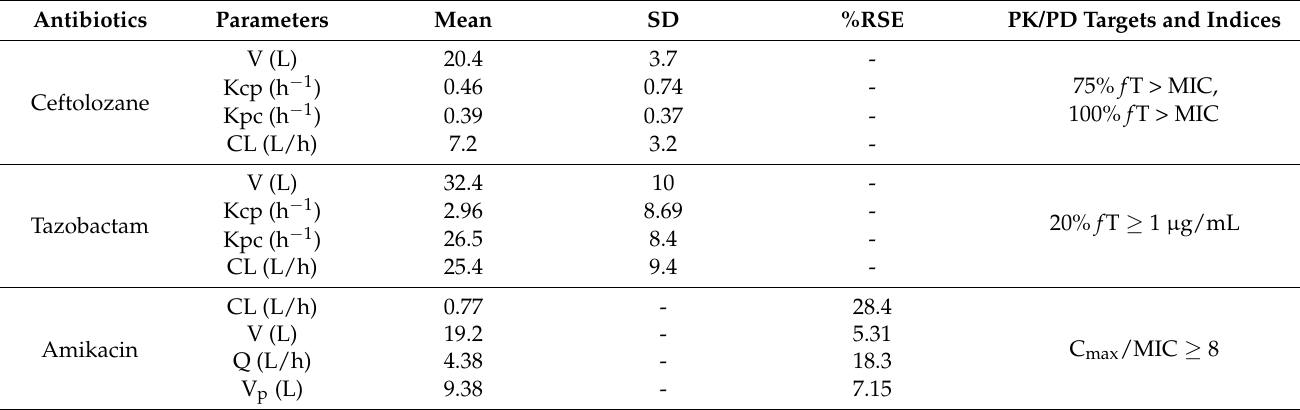
Table 8. Pharmacokinetic parameters, the PK/PD targets, and indices of ceftolozane/tazobactam (C/T) and amikacin used for the